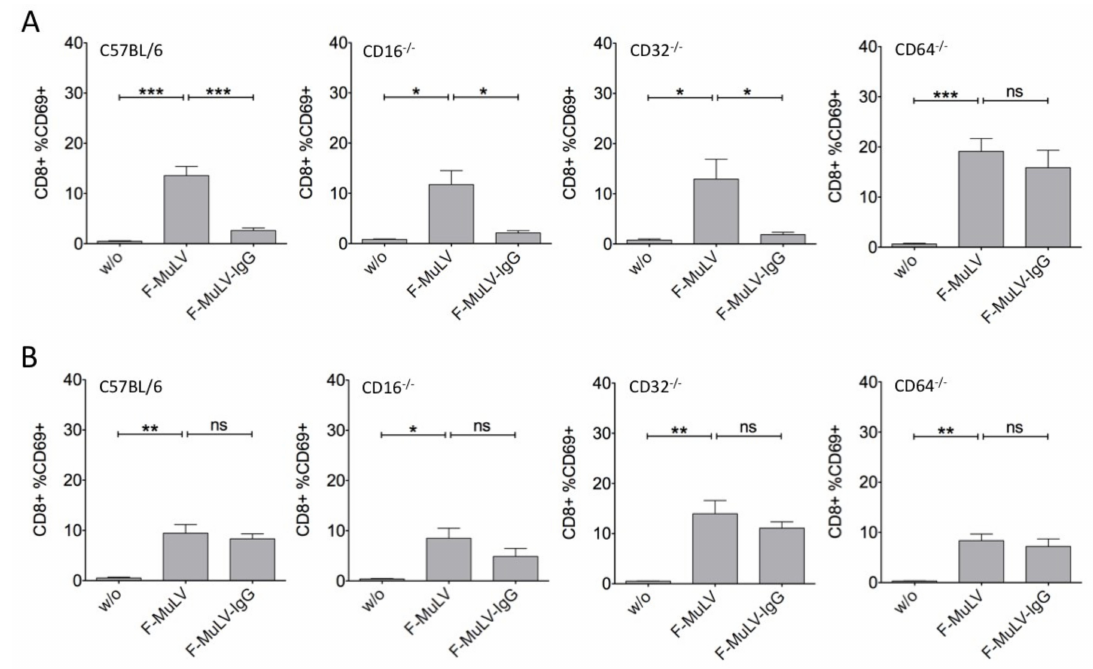
Figure 5. Impairment of specific CD8 T cell activation by F-MuLV-IgG loaded DCs is mediated by Fc γ receptor type I (Fc γ RI) (CD64). 5 × 10 5 ( A ) bmDCs or ( B ) B cells derived from C57BL/6 wt or from Fc γ RI (CD64 − / − ), Fc γ RII (CD32 − / − ), or Fc γ RIII (CD16 − / − )-deficient mice were loaded with 5000 FFUs of F-MuLV or IgG-opsonized F-MuLV (F-MuLV-IgG) and cocultured with 5 × 10 5 isolated FV-specific TCRtg CD8 T cells. Activation of CD8 T cells was determined by the expression of the early activation marker CD69 gating on AAD-negative living CD8 singlets measured by flow cytometry after 48 h of coculture. Data represent mean ± SEM of three or four independent experiments. Data were analyzed by GraphPad PRISM software using ANOVA followed by Dunnet’s multiple comparison test (***, **, * significant at p < 0.001, p < 0.01, p < 0.05,